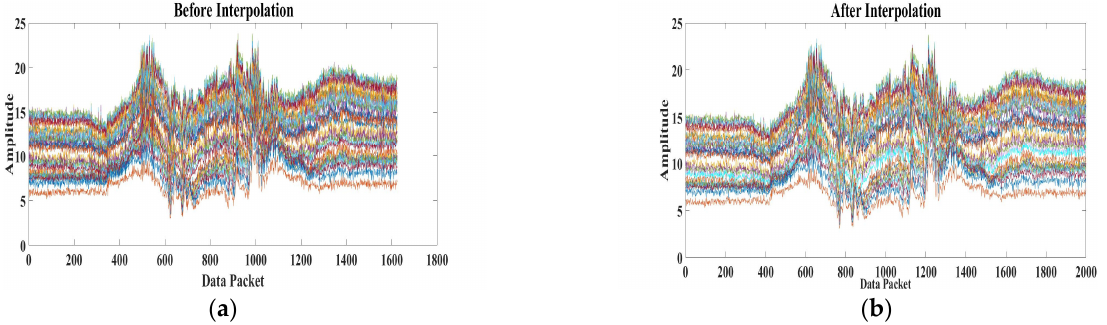
Figure 3. Changes before and after interpolation of 30 subcarriers ( a ) Before interpolation algorithm processing; ( b ) After interpolation algorithm processing.